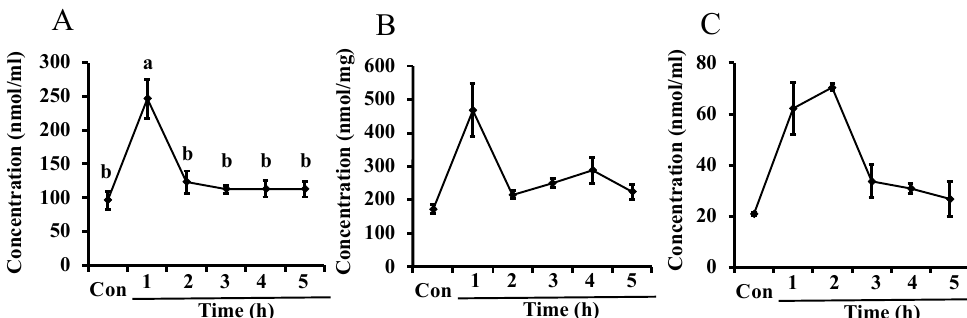
Figure 2. Levels of L-ornithine in maternal plasma ( A ), the mammary glands ( B ), and milk ( C ) after oral administration of L-ornithine in Experiment 2. Data are expressed as means ± SEM. n = 3–5/group. Con: control. In Figure 2A, the 1 h value marked with the letter “a” is significantly higher than the other values marked with the letter “b” at p < 0.05.